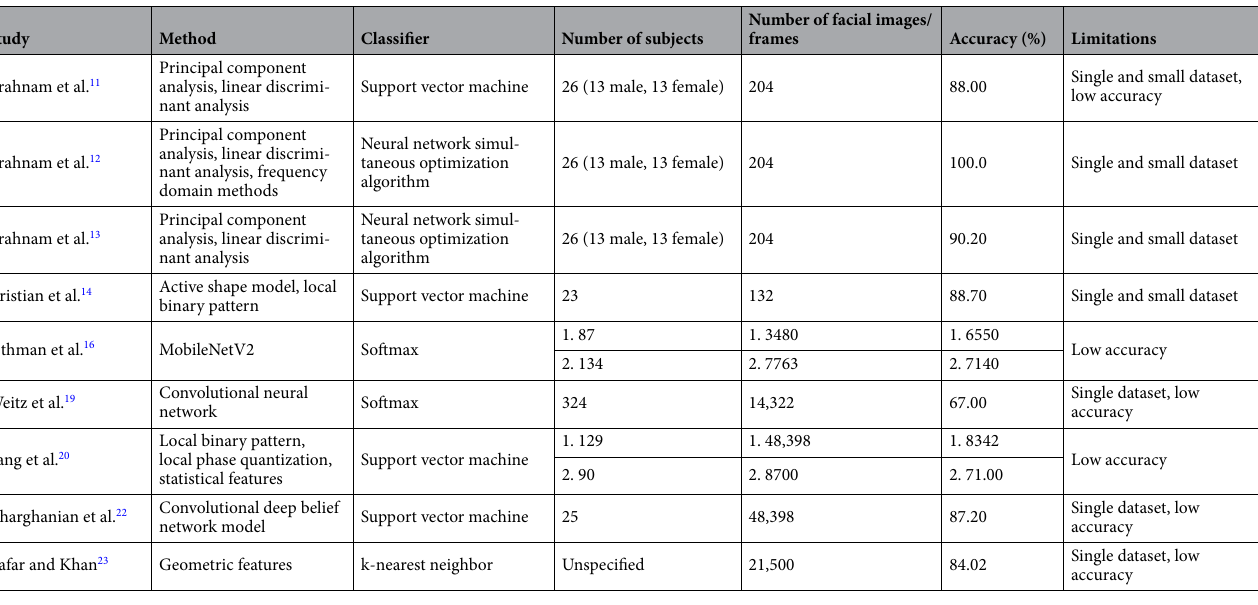
Table 1. Summary of the state-of-the-art for automated pain level detection using facial